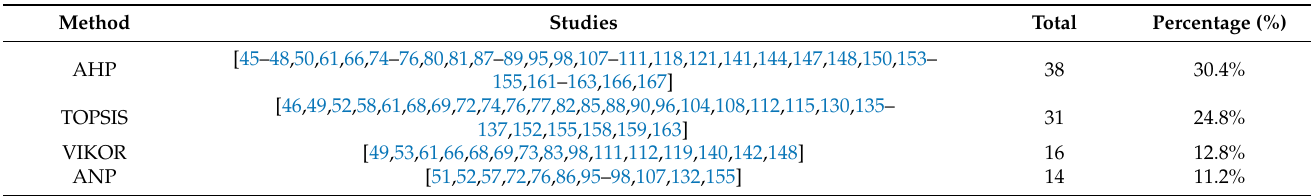
Table 2. The four most prominent decision approaches used in the CES study (window 2018 to 2021).